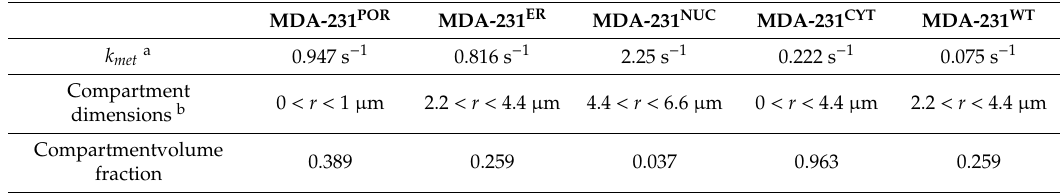
a Values from Figure 3A scaled to the volume of the appropriate compartment. b Radial inward